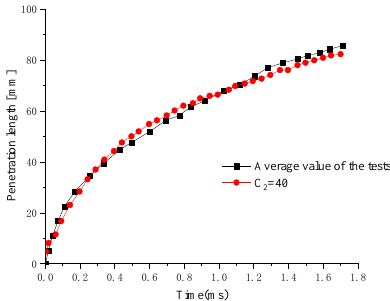
Figure 8. Comparison of the liquid penetration lengths between the simulated and experimental results for Case 2.